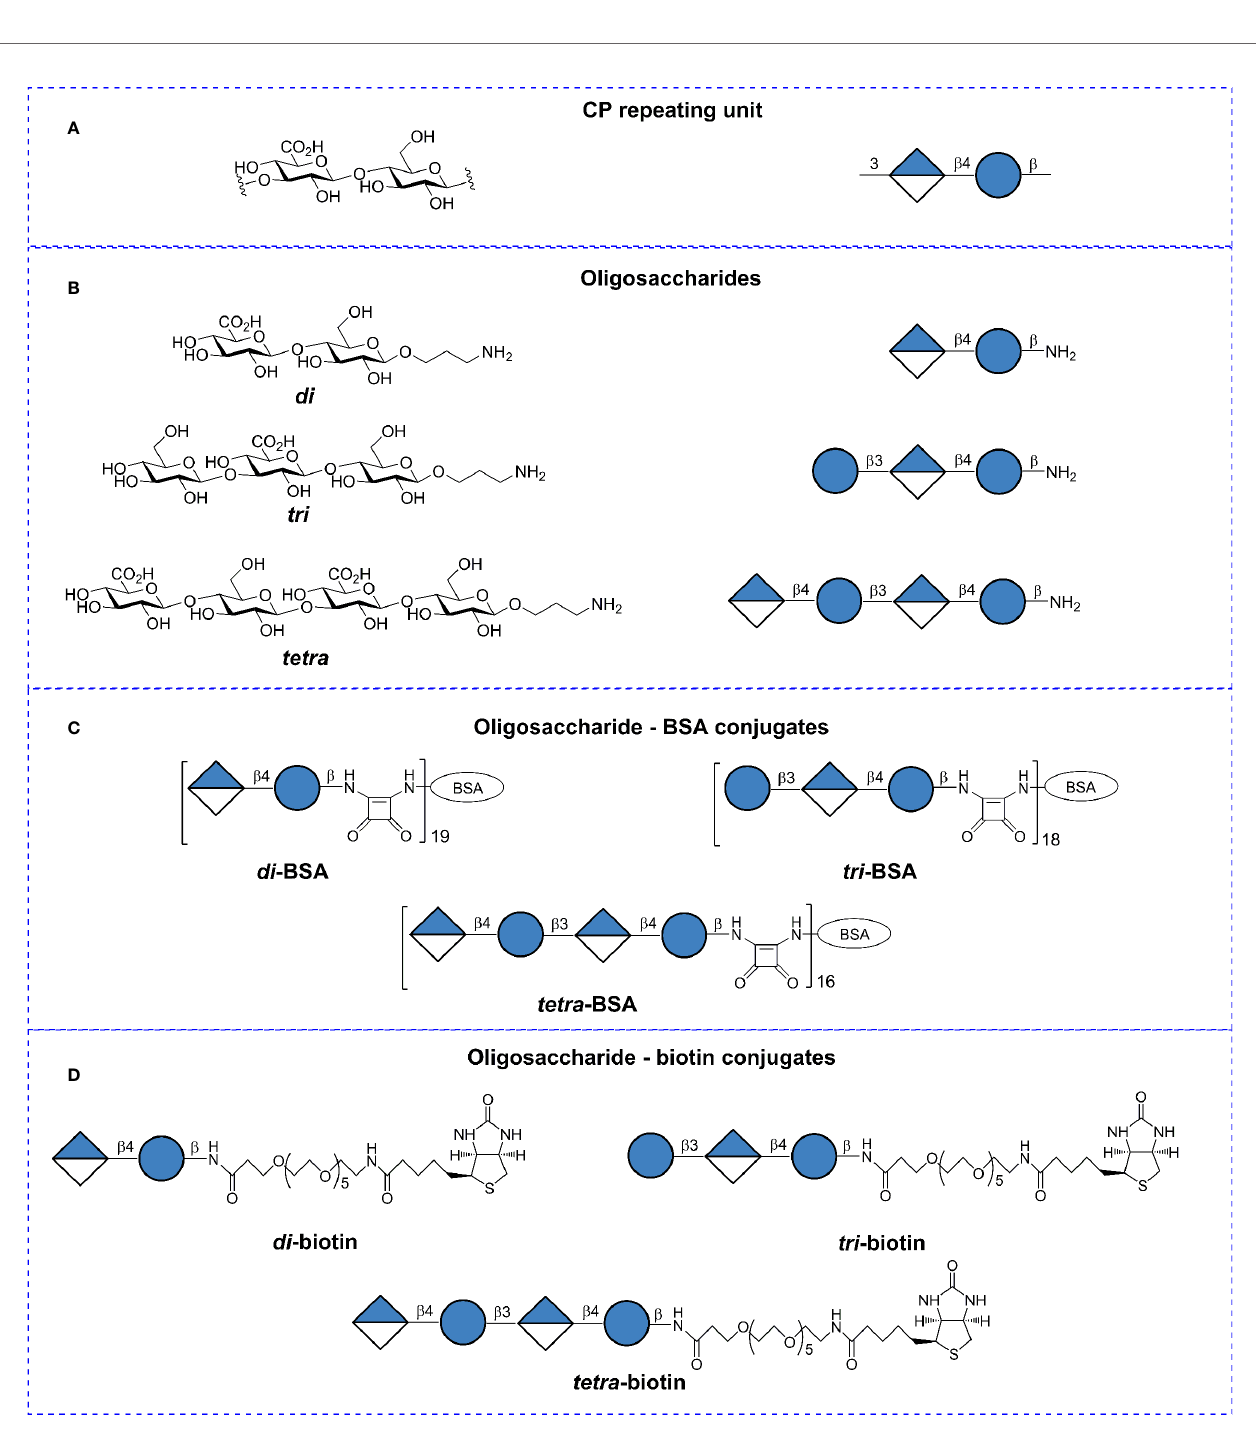
FIGURE 1 | Structures of the Streptococcus pneumoniae type 3 capsular polysaccharide (CP), synthetic oligosaccharides (OSs), and glycoconjugates. (A) Repeating unit of the S. pneumoniae type 3 CP. (B) Synthetic spacer-armed OSs representing the CP-fragments. (C) BSA conjugates of synthetic OSs. (D) Biotin conjugates of synthetic OSs. Structural and symbolic representations are assigned according to symbol carbohydrate nomenclature for the carbohydrate sequences